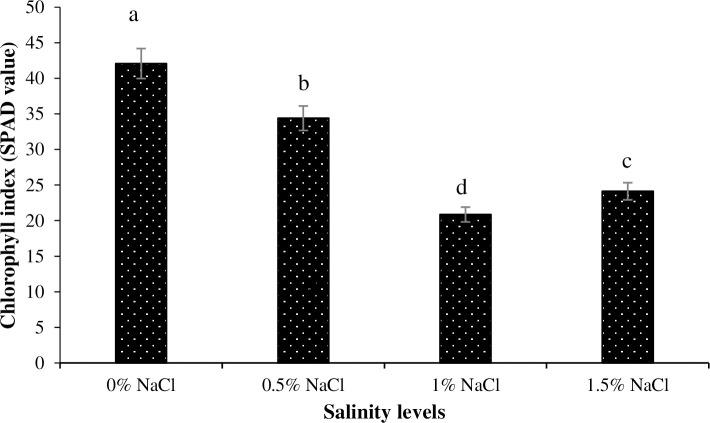
The influence of different NaCl salinity levels on chlorophyll index of Basil (Ocimum basilicum L.).The vertical bars are means ± standard errors. Any two means having different letters are statistically different from each other (p < 0.05).